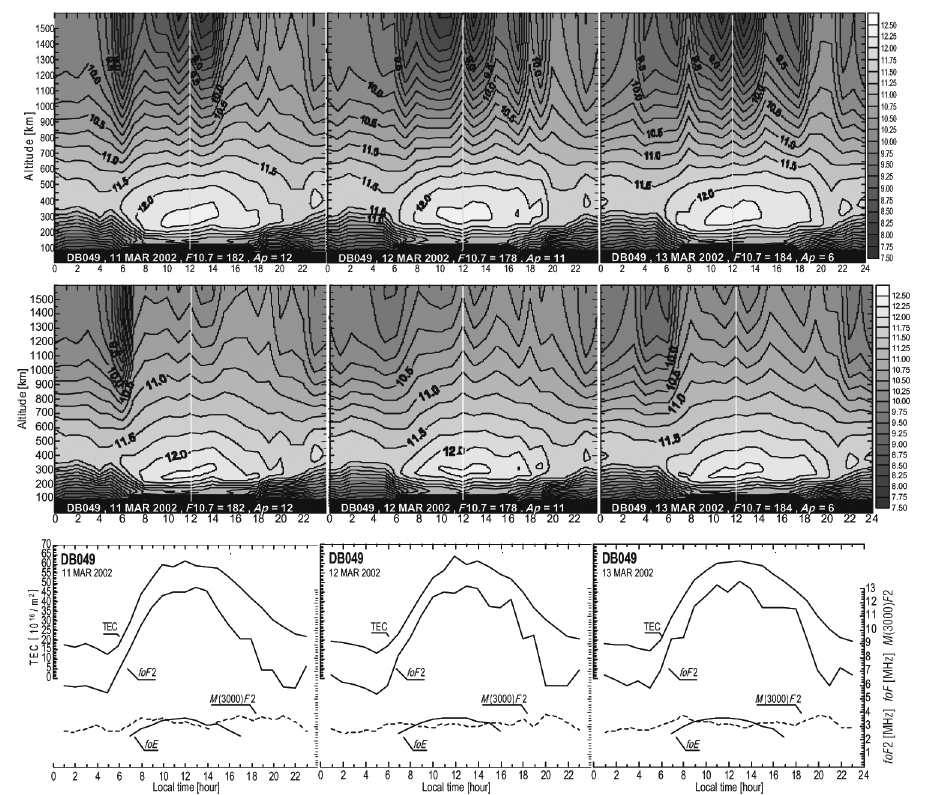
Fig. 3.5. Real-time reconstruction of the electron density profiles, 11-13 March 2003, Dourbes (4.6°E, 50.1°N). Top panels: reconstruction using the Sech-squared profiler. Middle panels: reconstruction using the Sech-squared profiler for night-time conditions and the Exponential profiler for day-time. Bottom panels: ionosonde and GPS-TEC measurements used as inputs to the